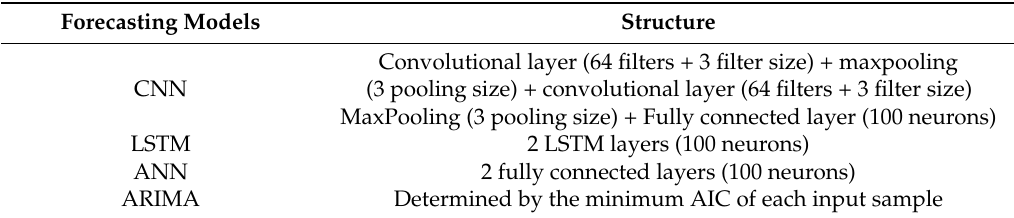
Table 4. The structure of the other forecasting models used as